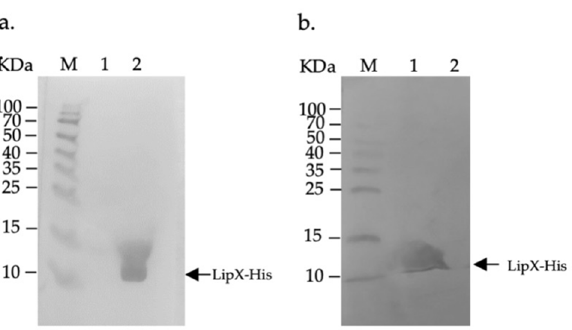
Figure 2. Analysis of the humoral immune response using Western blotting. ( a ) Confirmation of LipX-His protein expression using the HRP-labeled anti-His antibody detector: Lane 1, cell lysate from the culture of E. coli BL21 containing the pET28a- lipX plasmid without IPTG induction; Lane 2, cell lysates from the IPTG induction culture of E. coli BL21 containing the pET28a- lipX plasmid; ( b ) Proving the humoral immune response using serum pcDNA3.1- lipX -immunized mice to determine the expression of the LipX-His protein: Lane 1, cell lysates from the IPTG induction culture; Lane 2, cell lysates from the culture without IPTG induction. KDa—kilo Dalton; M—marker.